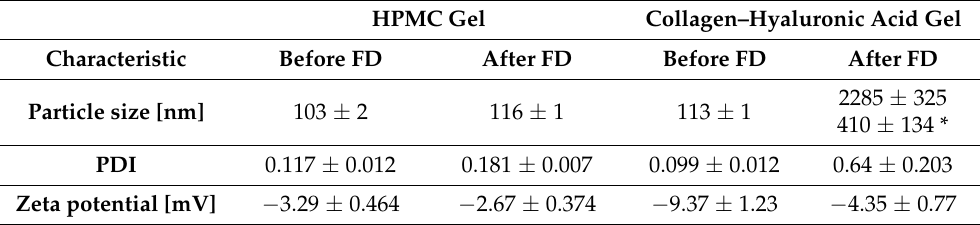
Table 2. DLS data of the hydrogel preparations. HPMC Gel Collagen–Hyaluronic Acid Gel Characteristic Before FD After FD Before FD After FD Particle size [nm] 103 ± 2 116 ± 1 113 ±